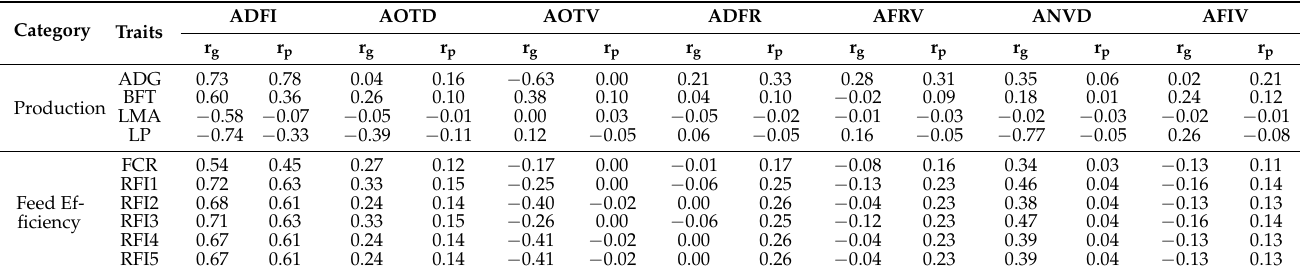
Table 5. Genetic ( r g ) and phenotypic correlation ( r p ) of feed efficiency traits with production traits and feed intake of Duroc